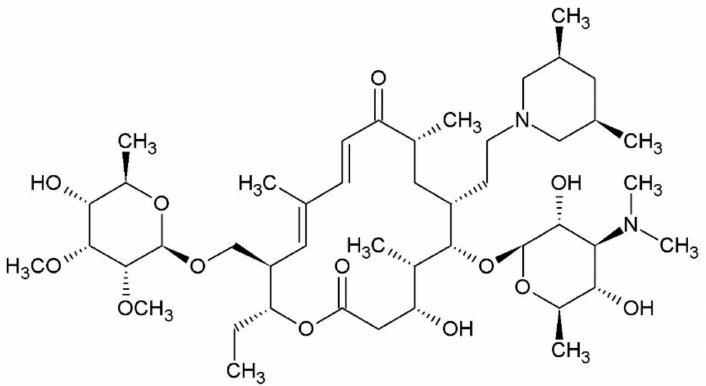
Figure 1. Chemical structure of